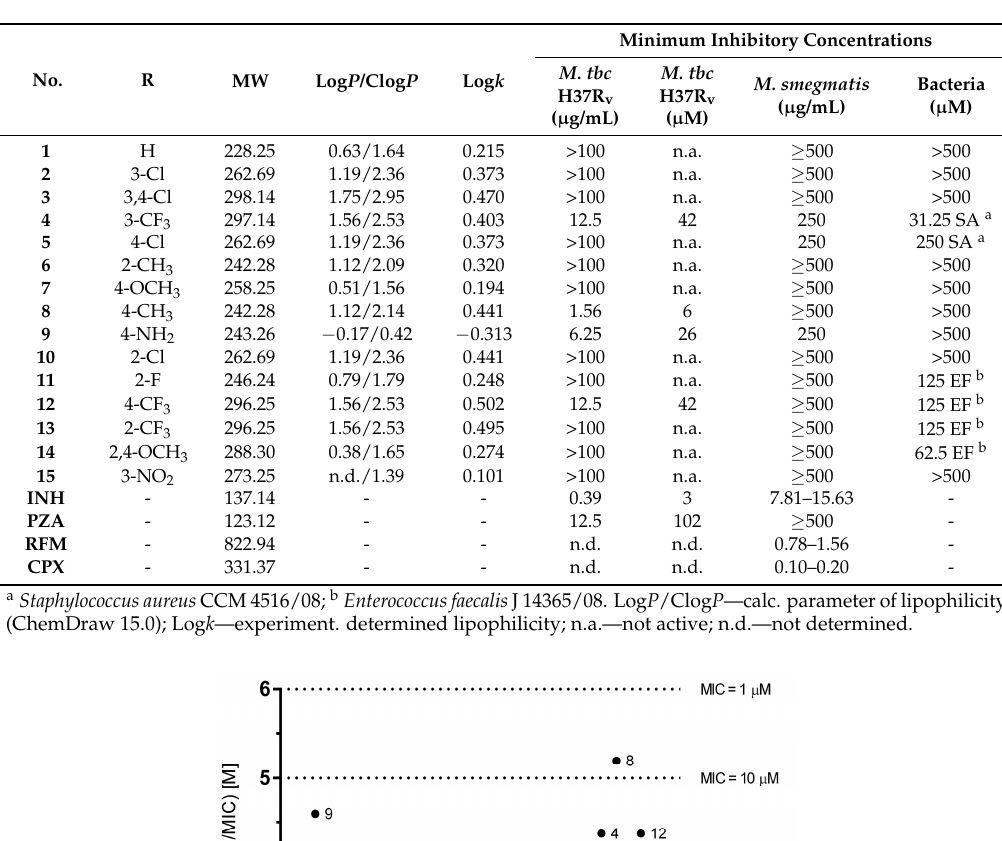
Table 1. Summary of prepared compounds, calculated and measured parameters of lipophilicity, results of antimycobacterial and antibacterial evaluation expressed as minimum inhibitory concentration (MIC) compared to standards.